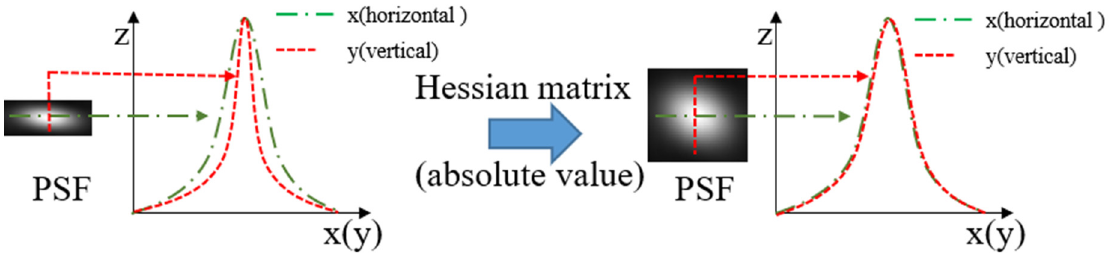
Figure 3. Change of PSF after being processed by the Hessian matrix.